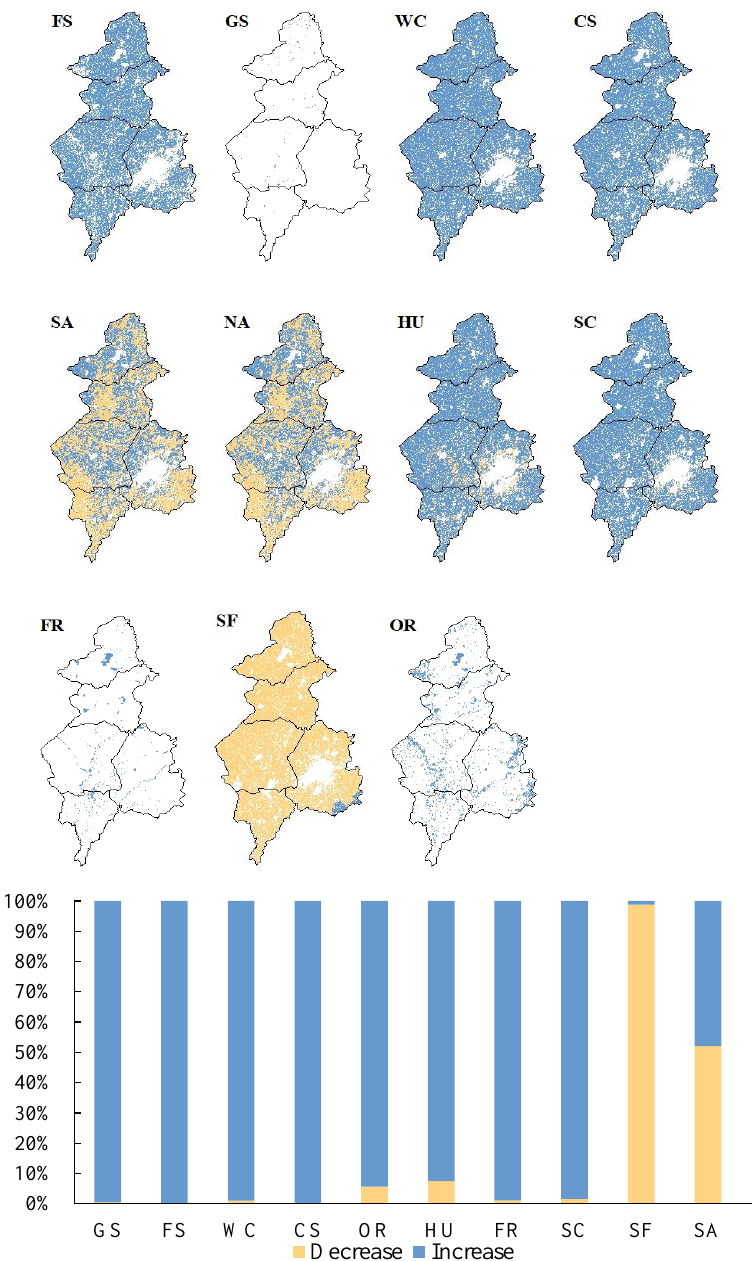
Figure 2. Spatial distribution of increases and decreases in ES during 2000 and 2019, food supply (FS), grass supply (GS), water conservation (WC), carbon sequestration (CS), SO 2 absorption (SA), NO x absorption (NA), humidification (HU), soil conservation (SC), flood regulation (FR), soil fixation (SF), and outdoor recreation (OR).